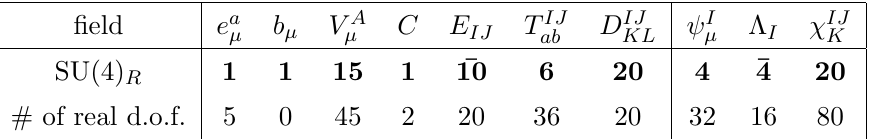
Table 9 . Field content of the Weyl multiplet in N = 4 conformal